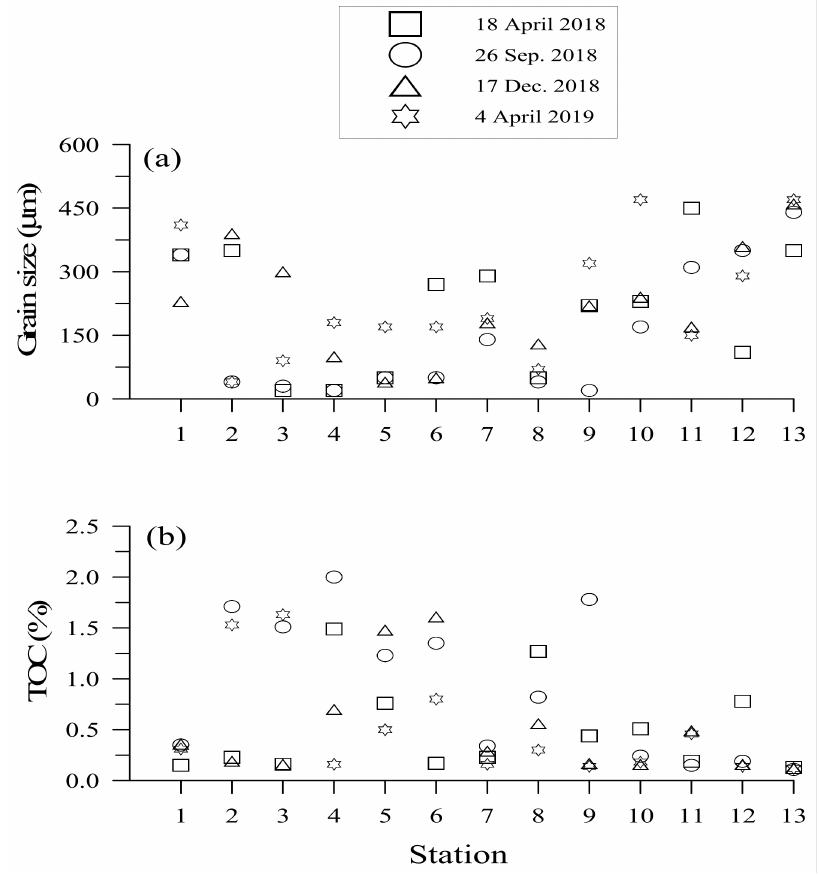
Figure 4. Seasonal distribution of ( a ) grain size and ( b ) TOC in the DRE surface sediments.